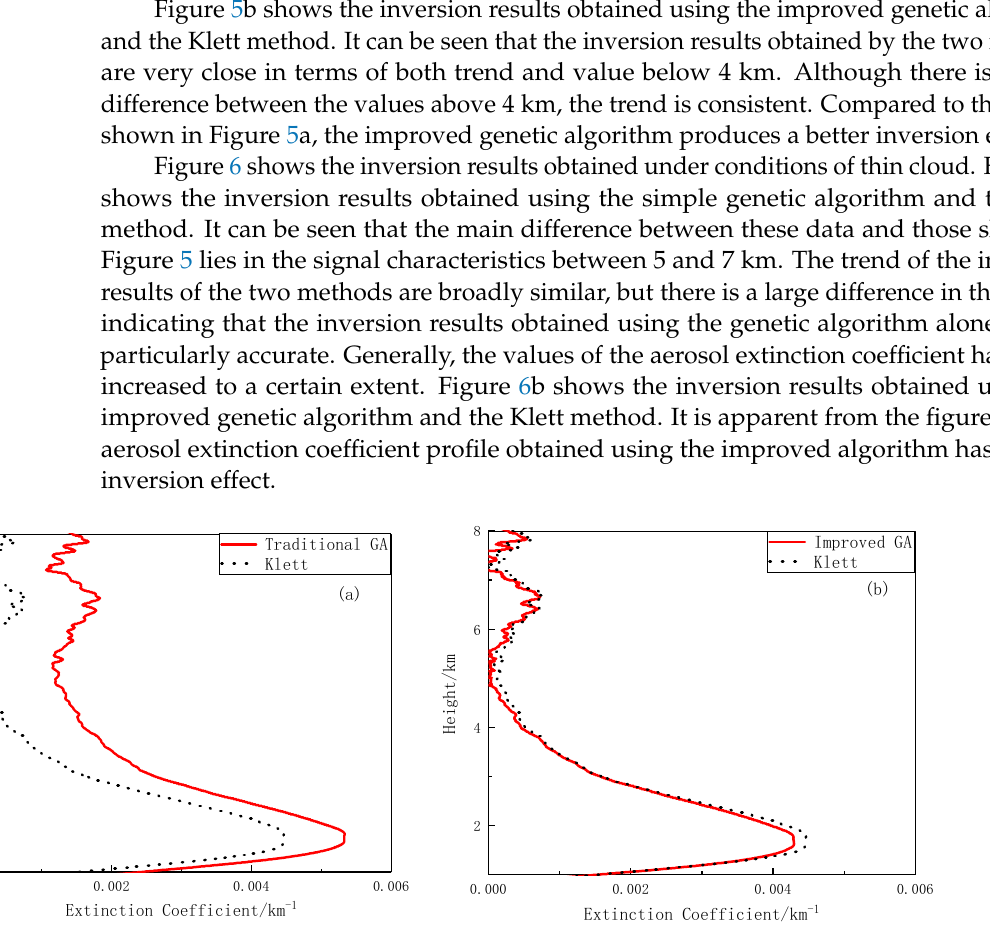
Figure 6. Inversion results obtained under conditions with thin cloud: ( a ) using the simple genetic algorithm and the Klett method, ( b ) using the improved genetic algorithm and the Klett method.